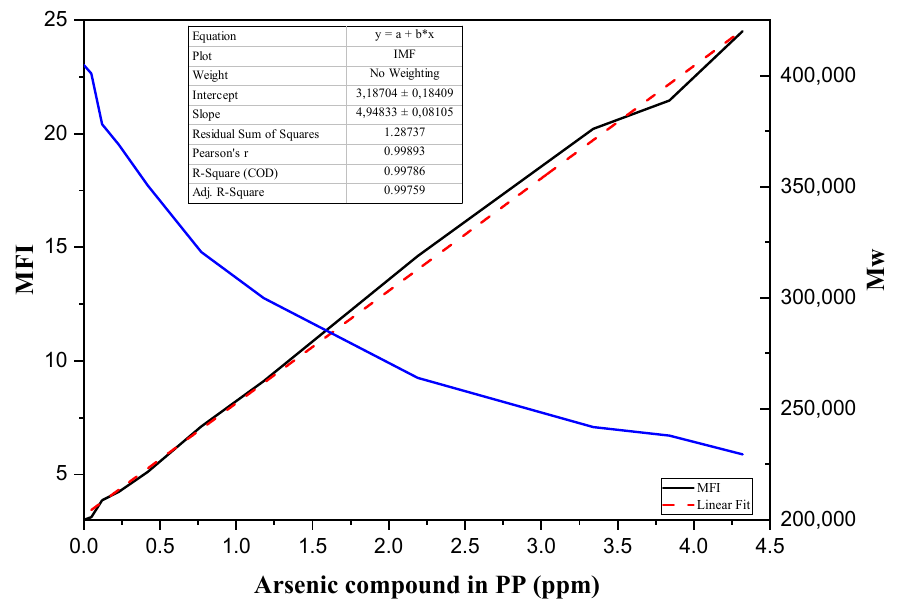
Figure 5. Relationship between the arsenic content in the PP and the MFI, and the variation of the M w .